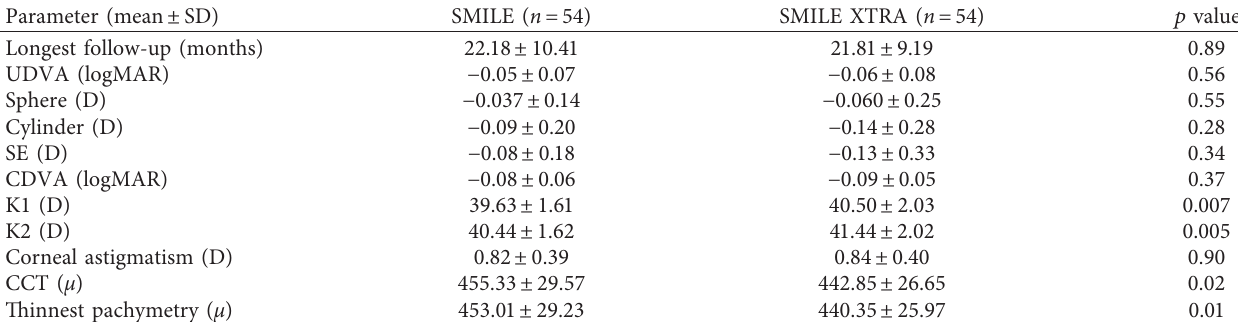
Table 2: Postoperative data at mean follow-up.